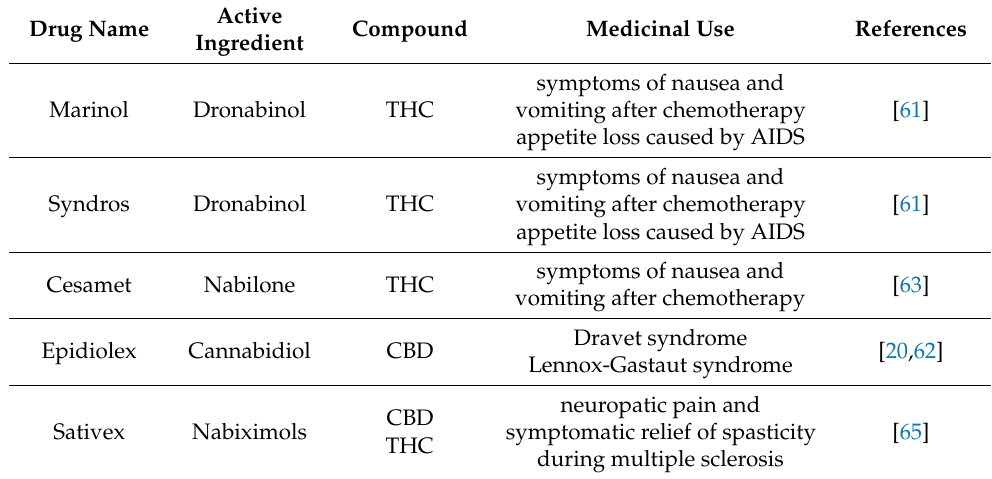
Table 1. Cannabinoids-based drugs approved by FDA for medical